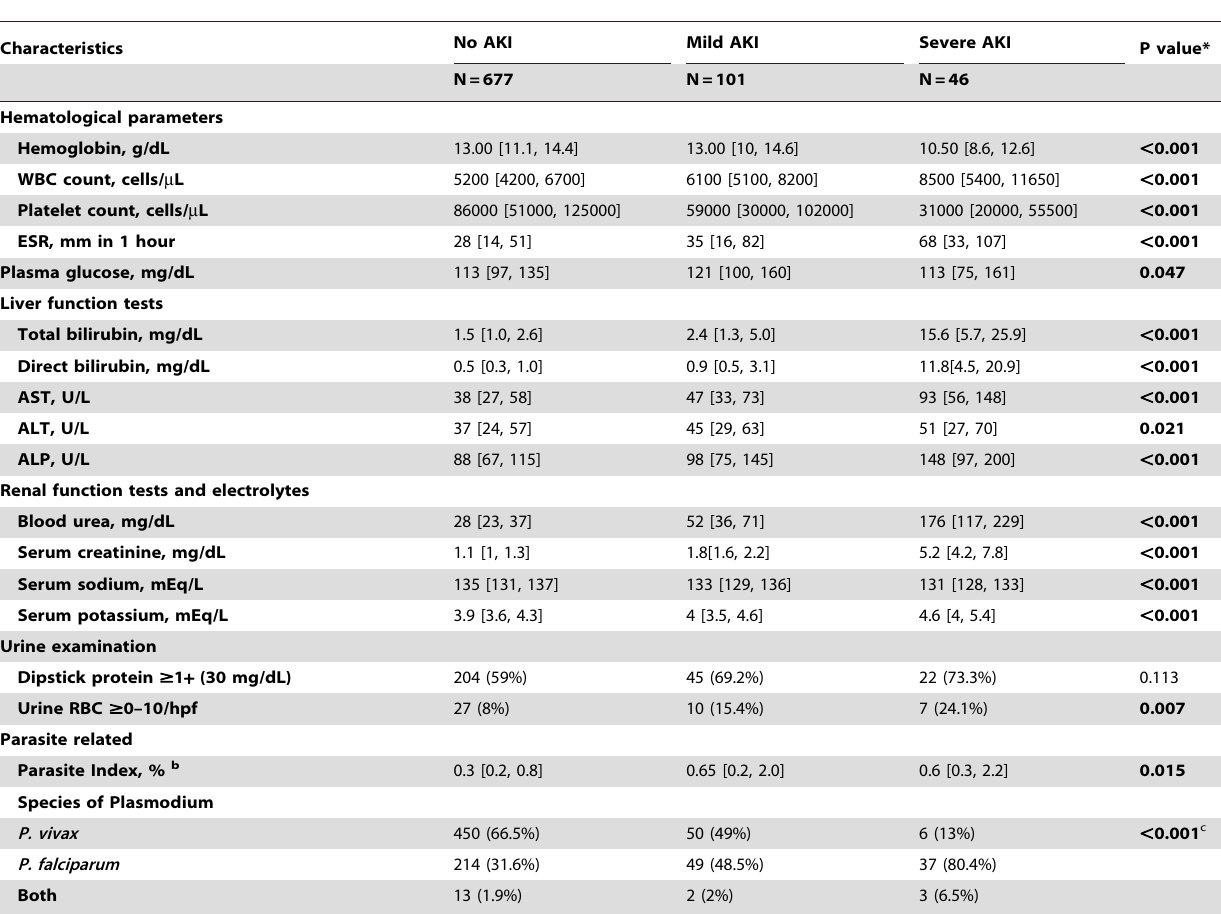
Table 2. Laboratory characteristics of the patients stratified by AKI categories. a